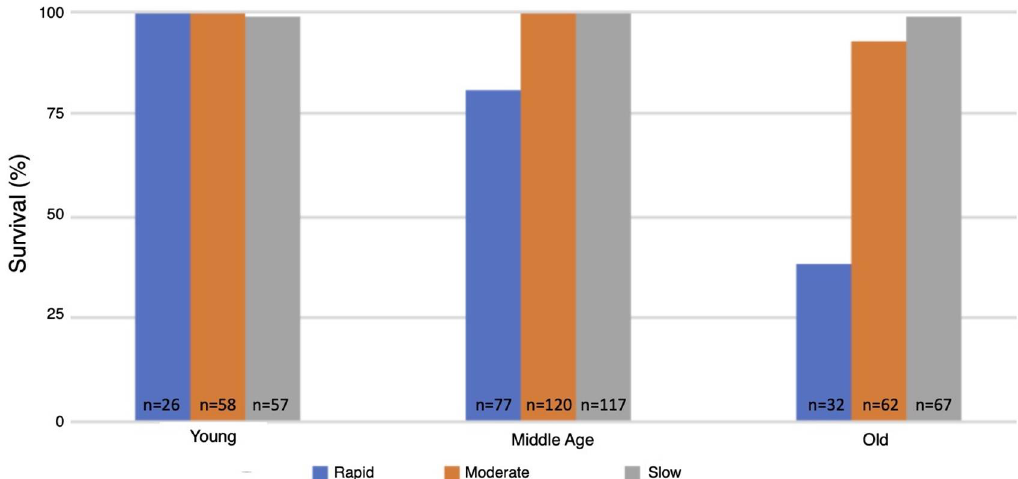
Figure 4. Survival following hypoxia of the MSR-deficient animals. The MSR-deficient (AB46) flies were subjected to 60 min hypoxia using the indicated flow rate of nitrogen. The flies were then returned to standard atmosphere and monitored for recovery from the coma as described in the legend of Figure 2. Animals that did not recover movement within 5 h were scored as not